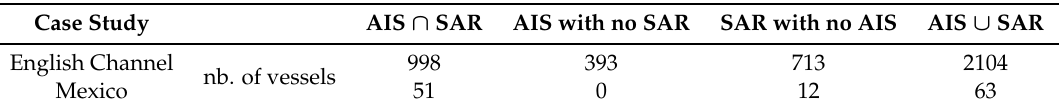
Table 2. Automatic identification system (AIS) and SAR cross-comparison, SAR detections derived by using the proposed dual-polarization algorithm.